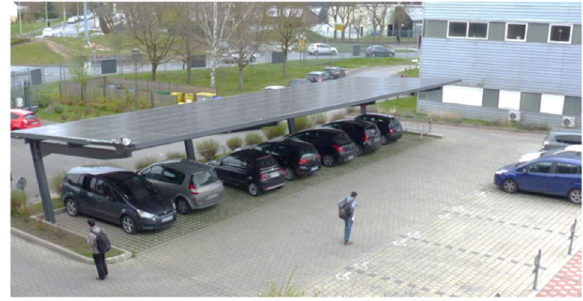
Figure 12. PV parking shade installation for nine spots.